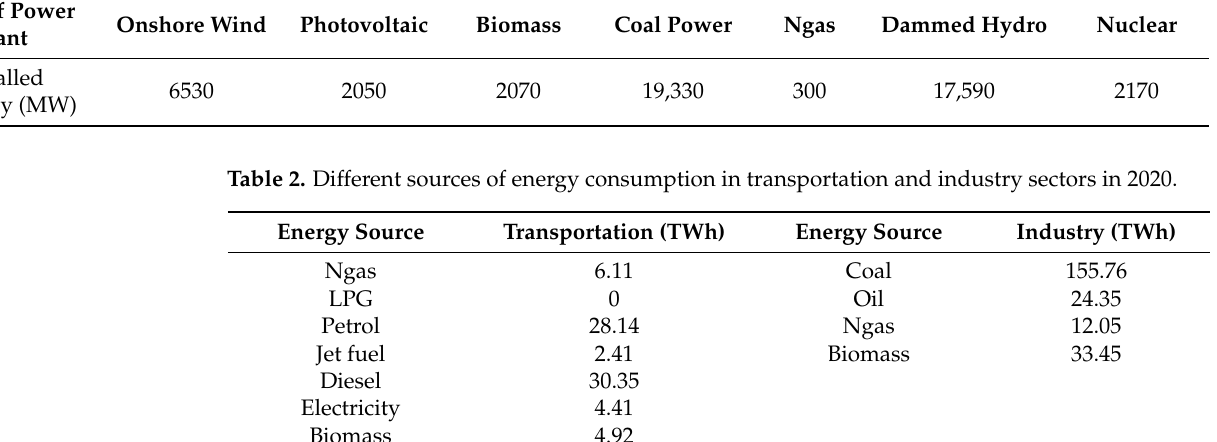
Table 1. The installed capacity of power generation technologies for Guangxi in 2020. Type of Power Plant